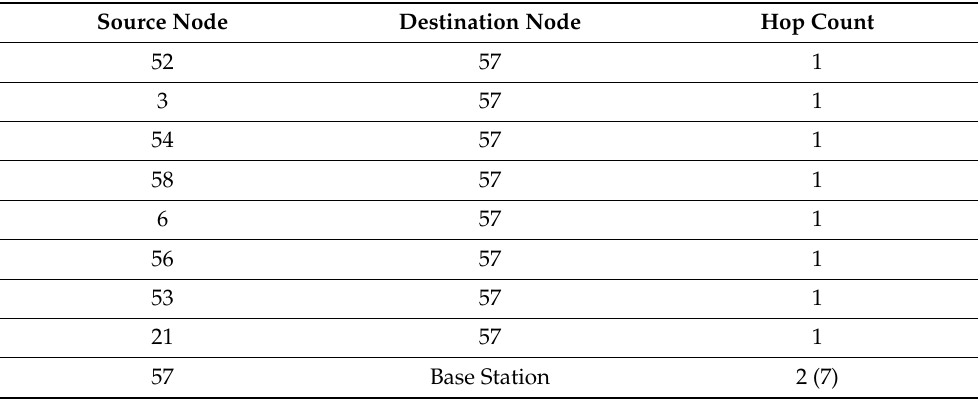
Table 4. The routing table of cluster